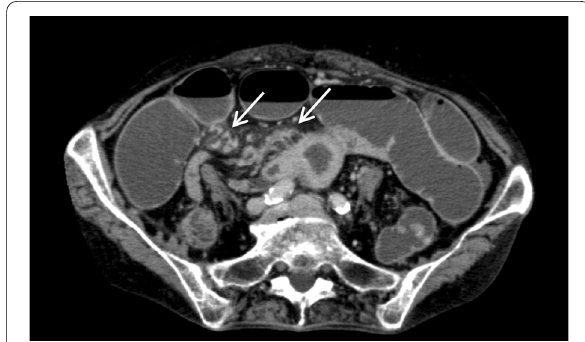
Fig. 6 The enlarged and winding peripheral marginal veins are observed on computed tomography (white arrow)